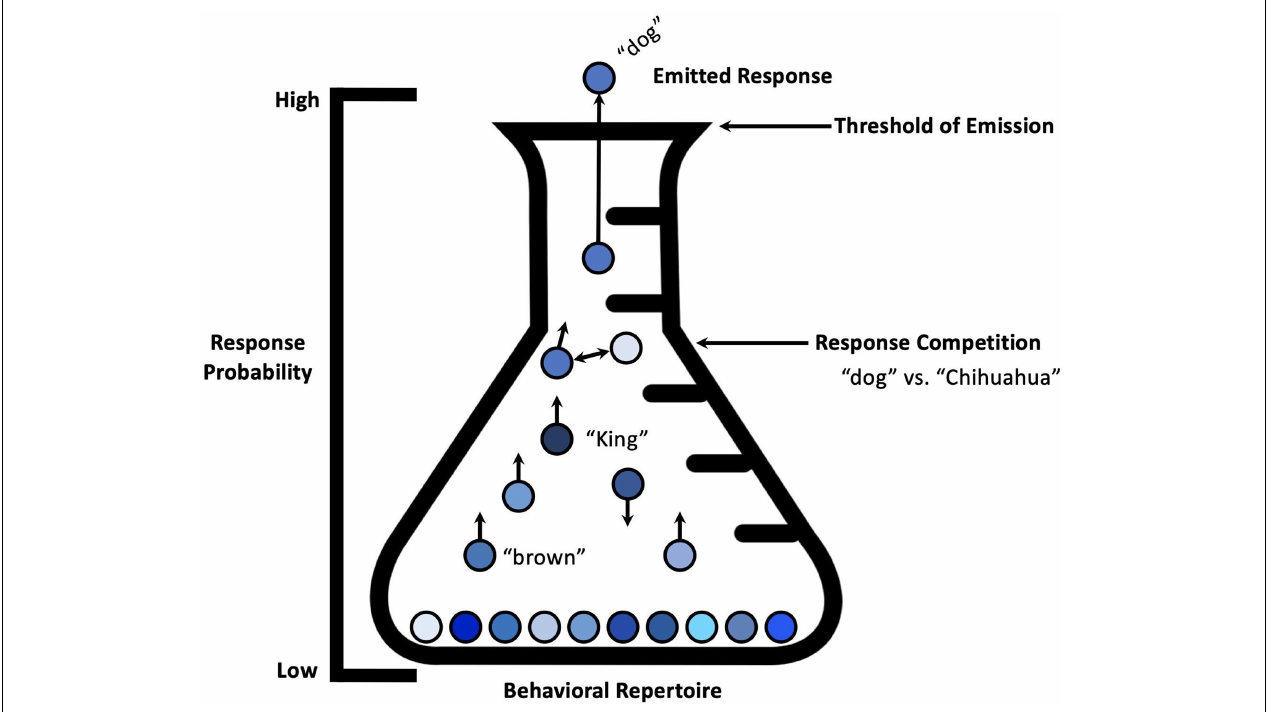
FIGURE 1 | Emission of a single response belonging to a single response system. A visual metaphor showing the emission of a single response, and the relative changes in response strength of responses within the same response system. Specific environmental conditions occasion a specific behavioral response, despite multiple members of the response class being suitable for a given situation. Response competition is characterized by bidirectional arrows between the particular responses within the response system. Adapted from “Response strength and the concept of the repertoire,” by Palmer